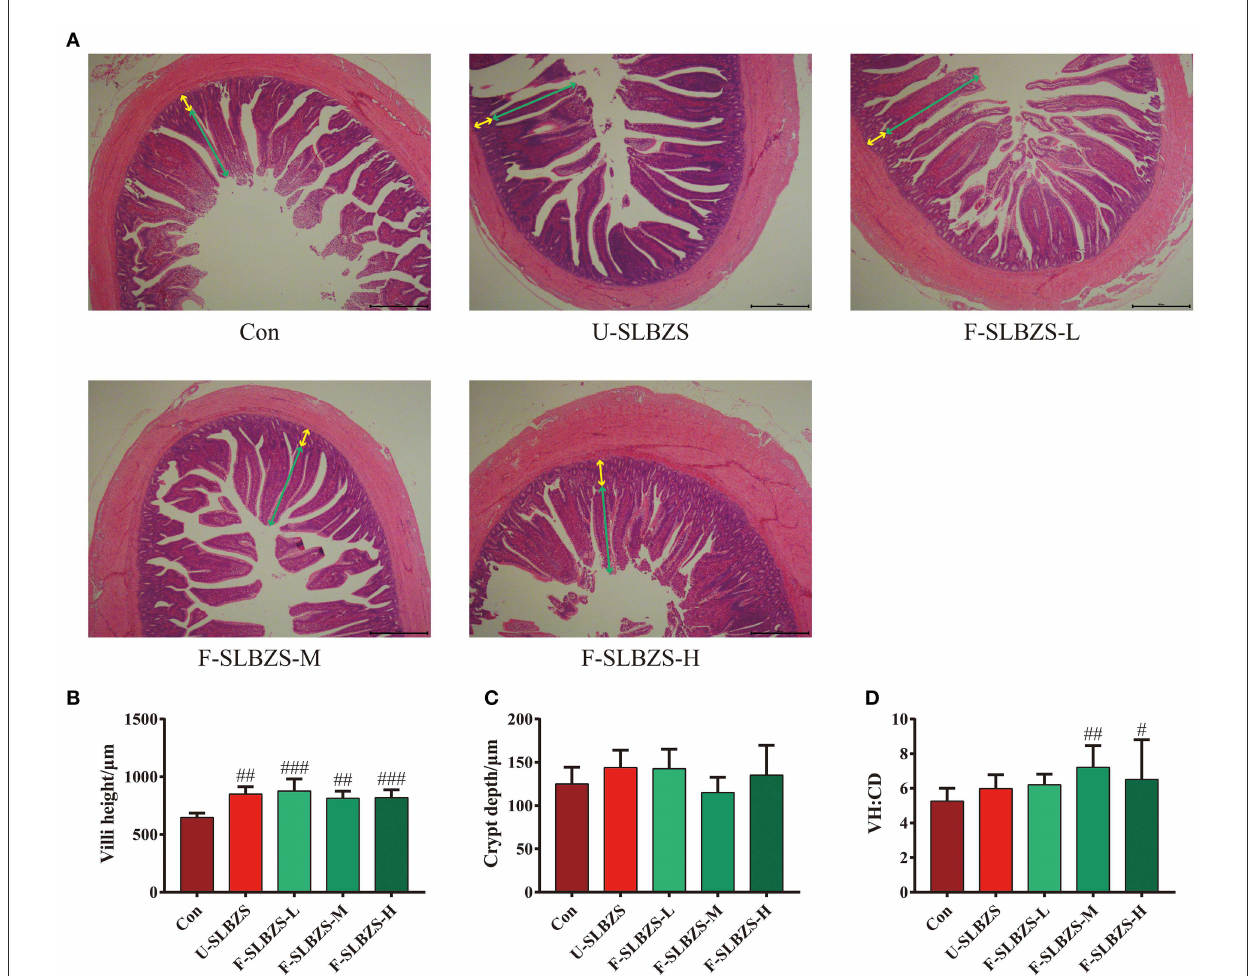
FIGURE5 Effects of fermented SLBZS on intestinal morphology of broilers. (A) H&E of broiler ileum. Green arrow: villi height, Yellow arrow: crypt depth. Scale: 200 µ m. (B) Villi height in ileum of broilers. (C) Crypt depth of ileum in broilers. (D) Villi height to crypt depth (VH:CD) ratio ileum of broilers. Bars represent mean values ± SD ( n = 5). # and ## indicate p < 0.05 and p < 0.01 compared with the Con